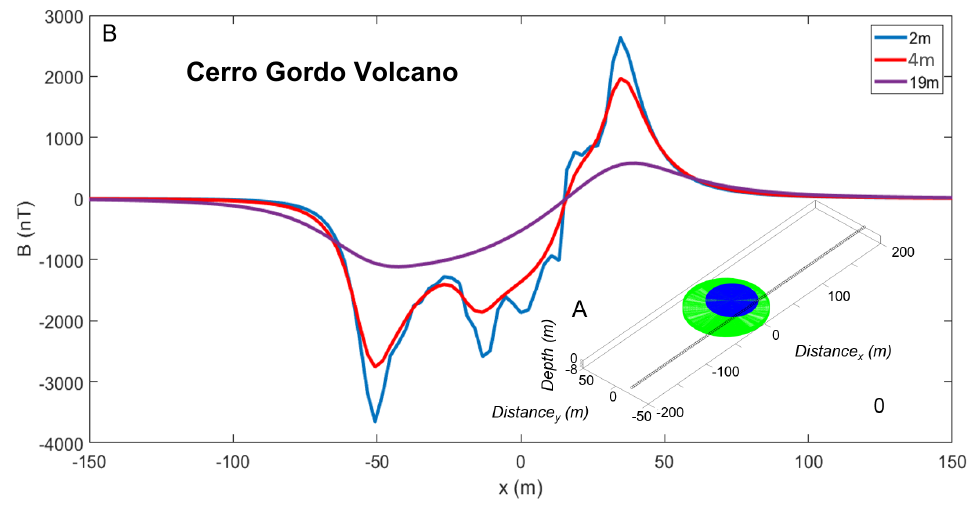
Figure 14. ( A ) Scheme of the simulated structure with three layers. ( B ) Numerical magnetic field generated by the model.